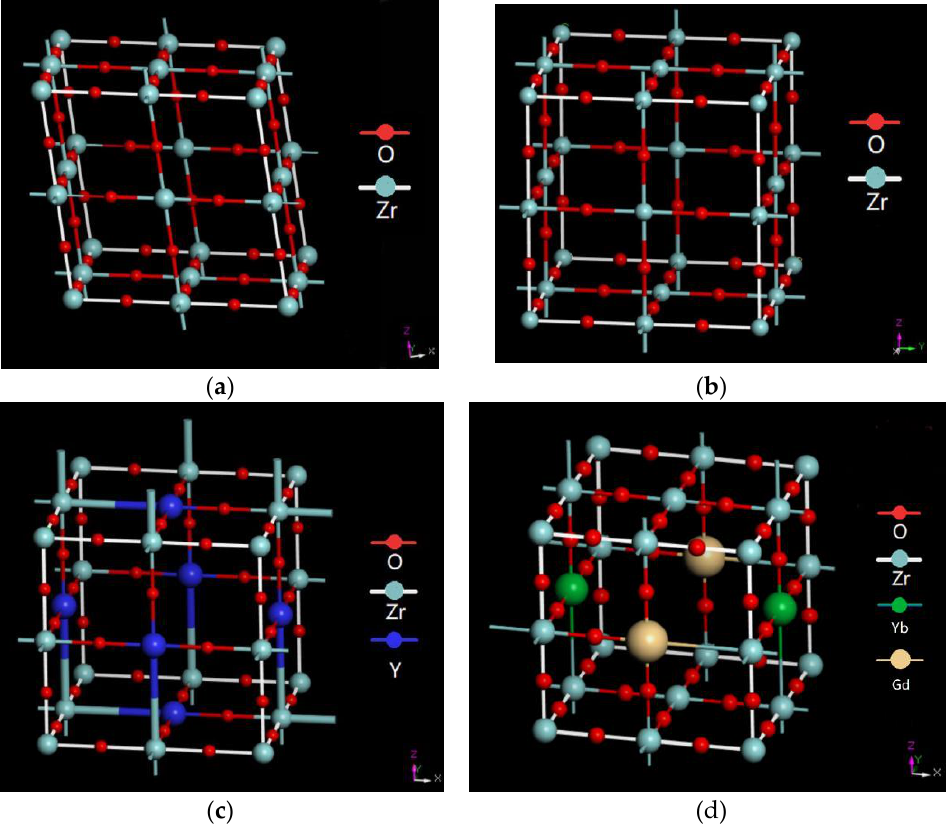
Figure 9. Crystalline structures of the ceramic: ( a ) M-ZrO 2 ; ( b ) T-ZrO 2 ; ( c ) T-8YSZ; ( d ) T-GYYZO. Table 7. Lattice parameters of the unit cells and the space group of the phases in the ceramics. Crystal